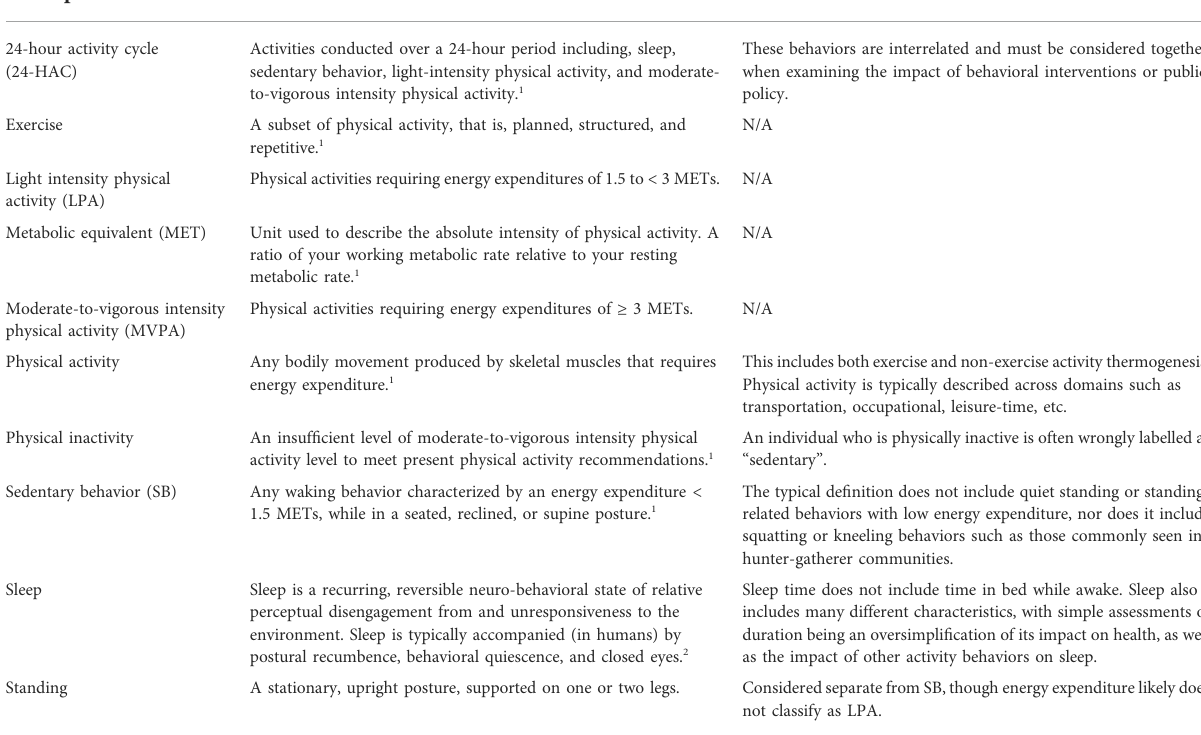
TABLE 1 Key concepts — de fi nitions and